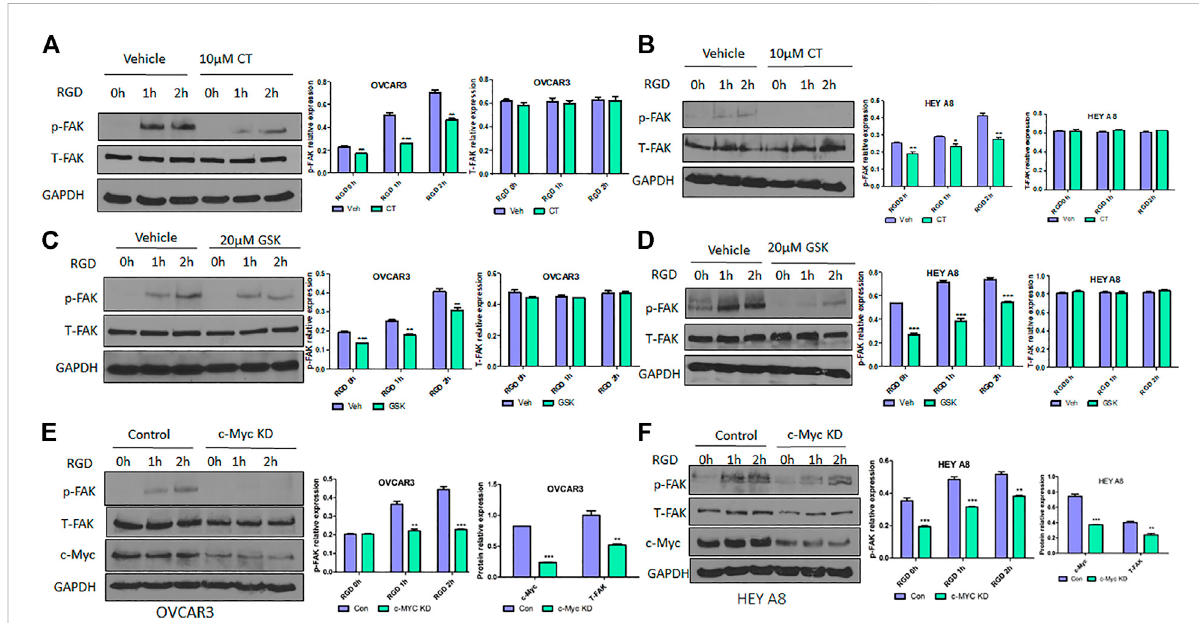
FIGURE 4 CT or genetic KD of c-Myc attenuates RGD-induced FAK activation in ovarian cancer cells. (A,B) Immunoblot and densitometry analysis of p-FAK and total FAK after treatment with 10 µM CT for 8 h and then 20 μ M RGD for different time periods in OVCAR3 (A) and HEY A8 (B) cells. (C,D) Immunoblot and densitometry analysis of p-FAK and total FAK after treatment with 20 µM GSK2256098 for 8 h and then 20 µM RGD for different time periods in OVCAR3 (C) and HEY A8 (D) cells. (E,F) Immunoblot and densitometry analysis of p-FAK, total FAK, and c-Myc expression in c-Myc KD and control OVCAR3 (E) and HEY A8 (F) cells after treatment with 20 µM RGD for different time periods. Data are presented as mean values ±SD. * p < 0.05, ** p < 0.01, *** p <